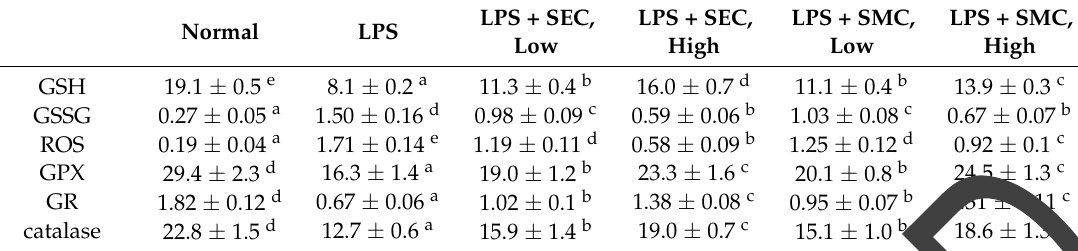
Table 3. Lung level of GSH (nmol/mg protein), GSSG (nmol/mg protein), ROS (RFU/mg protein), and activity (U/mg protein) of GPX, GR and catalase of mice in normal group, LPS group, LPS + low SEC group, LPS + high SEC group, LPS + low SMC group and LPS + high SMC group after 3-day treatments. Data are mean ± SD, n = 10.